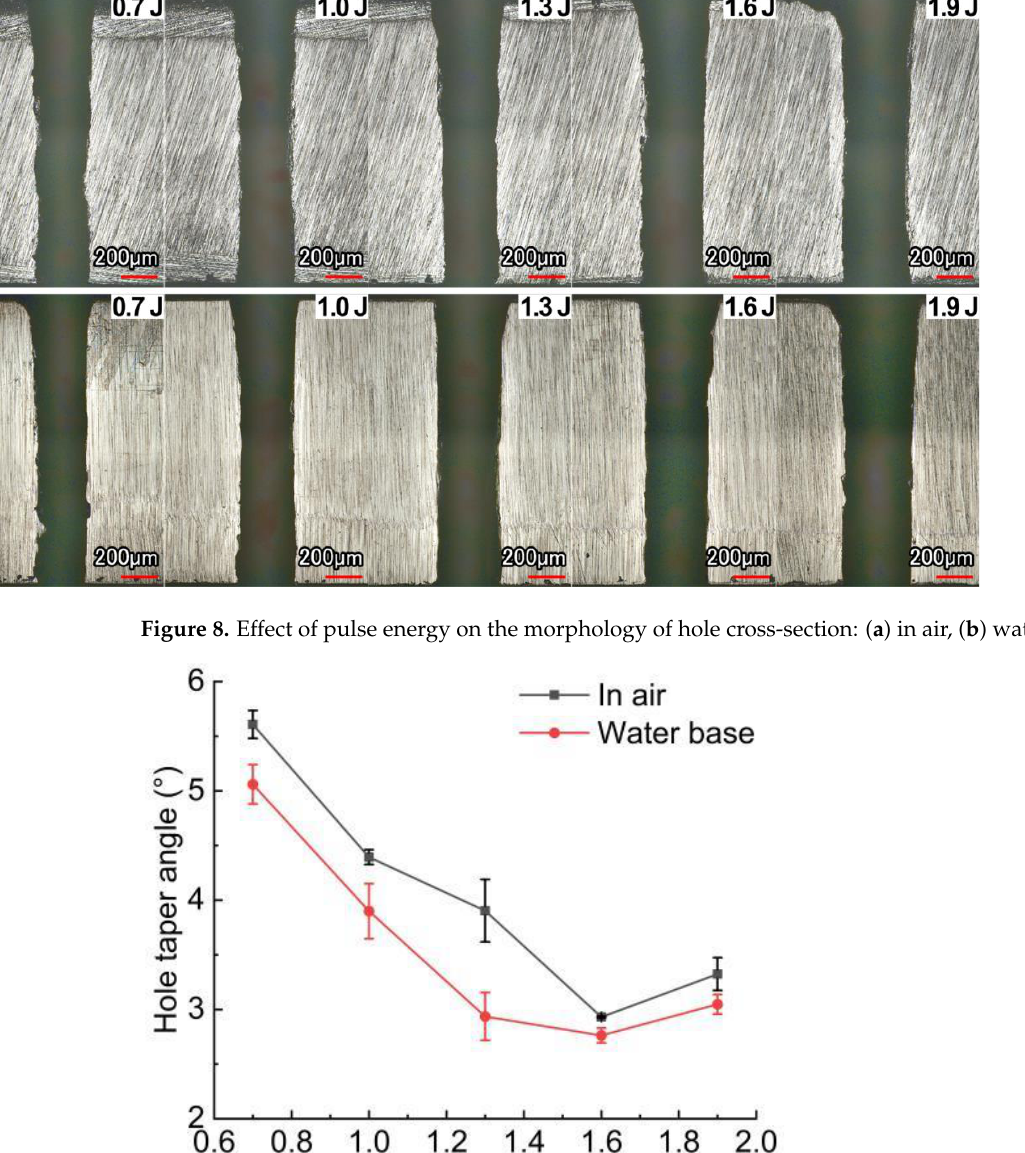
Figure 9. Effect of pulse energy on hole taper angle.